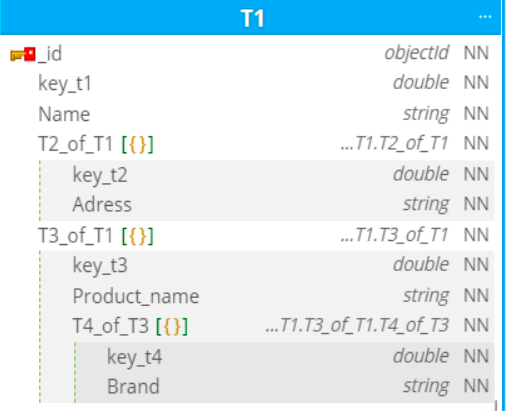
Figure 12. The new collection with sequential and multi-level embedded documents.